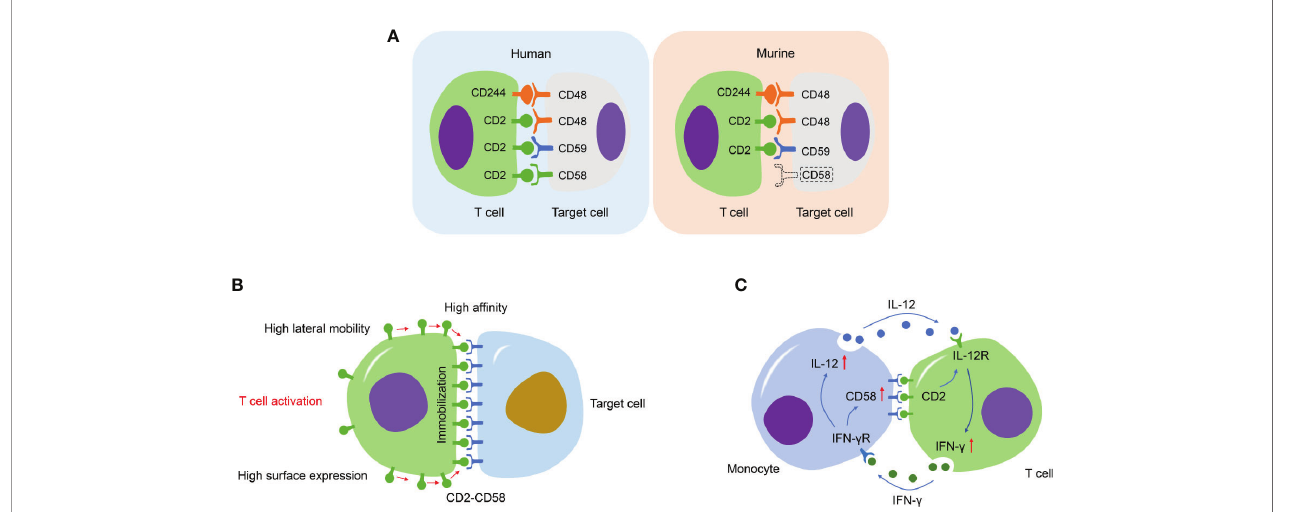
FIGURE 3 | Schematic diagram regarding CD2/CD58/CD48/CD59 system, CD2-CD58 immobilization in T cell activation, and IL-12/IFN- g feedback loop. (A) Speci fi c differences of reciprocal adhesion molecule between human and murine in the CD2/CD58/CD48/CD59 system. CD2 and CD244 (2B4) are presented at the surface of T/NK cells in human and murine. Speci fi cally, CD2-CD58 is the principal ligand-receptor pair. CD48 and CD59 are two additional and low-af fi nity ligands of CD2 in human. The CD48 receptor binds both CD2 and CD244, while the CD58 gene is absent in murine. (B) The immobilization of CD2-CD58 following T cell activation. This process consists of three important features, increased CD2 surface expression, the high af fi nity of CD2-CD58, and rapidly lateral mobility; a series of conformational changes is bene fi cial to strengthen intercellular adhesion and aid recognition. (C) The important role of CD2-CD58 interaction in the IL-12/IFN- g positive feedback loop between monocytes and activated T